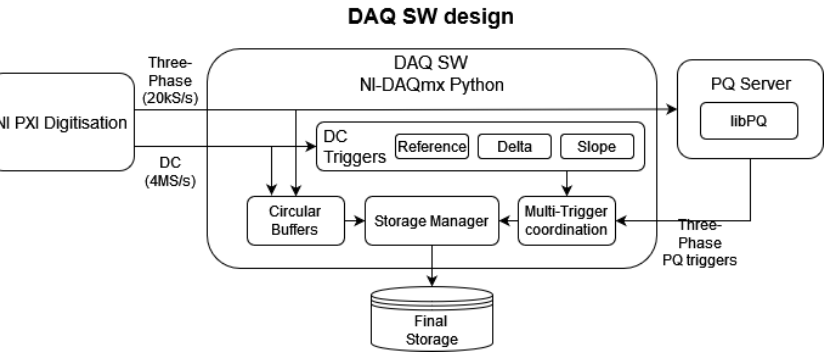
Figure 3. Data acquisition software